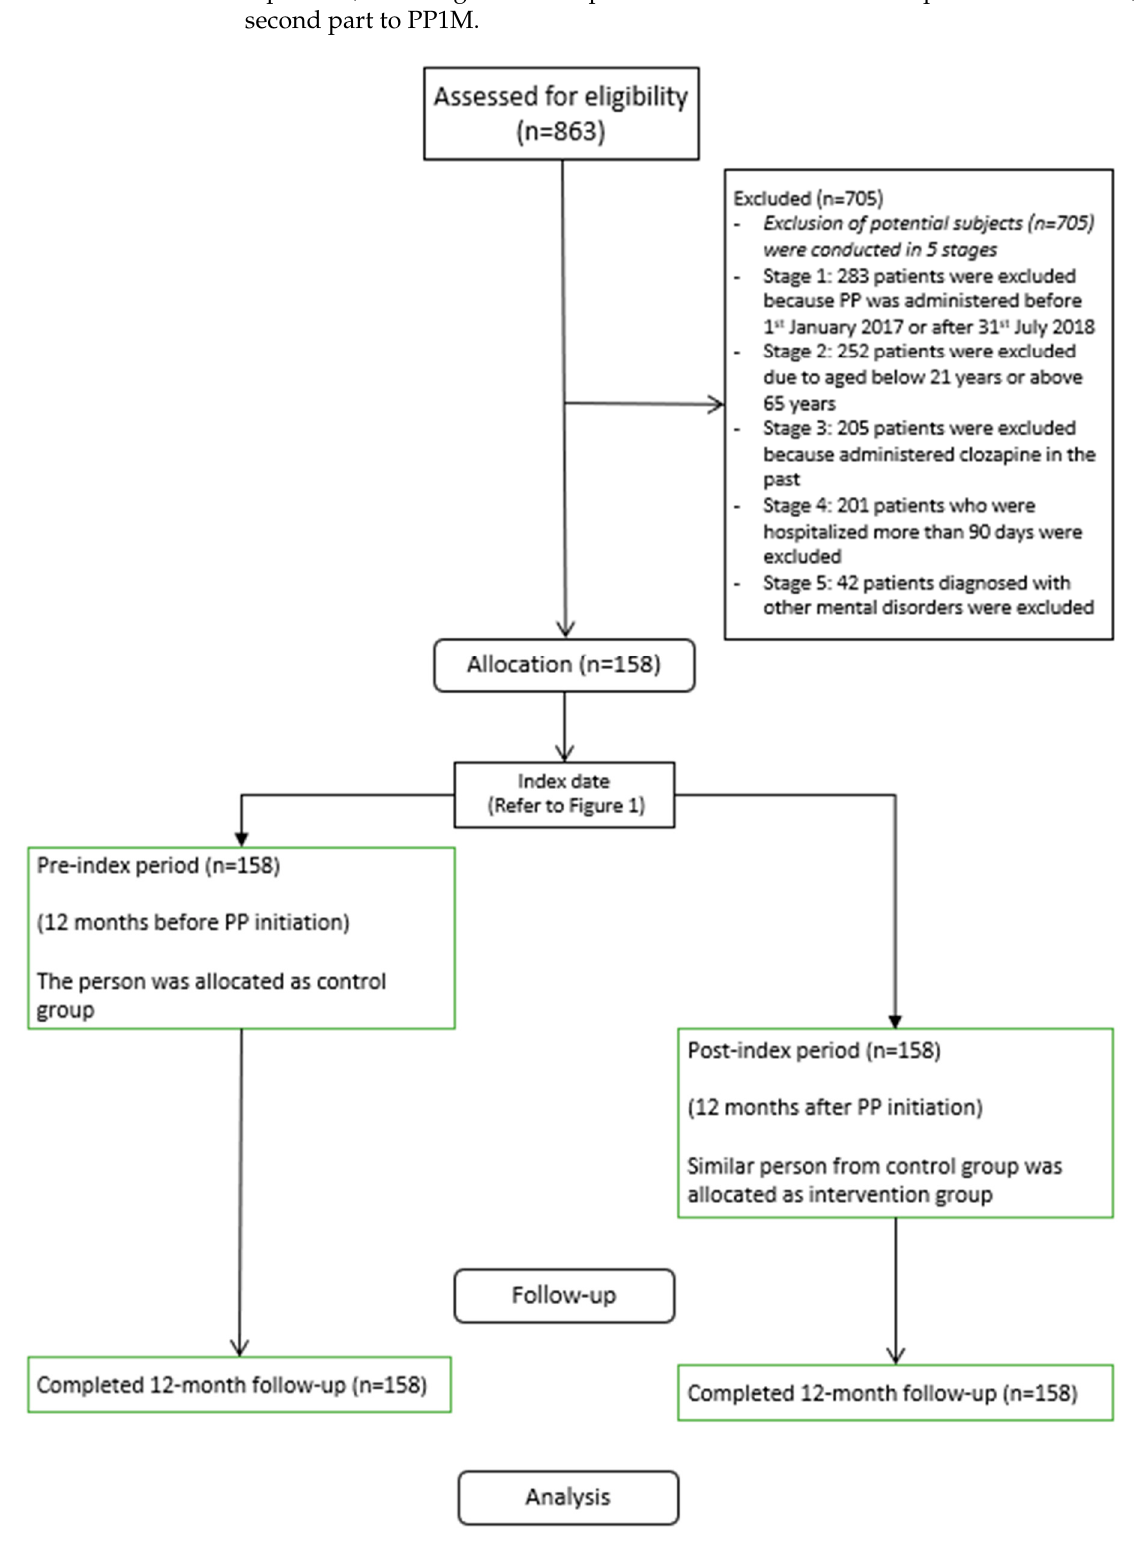
Figure 2. Modified CONSORT flow diagram for a mirror-image study.